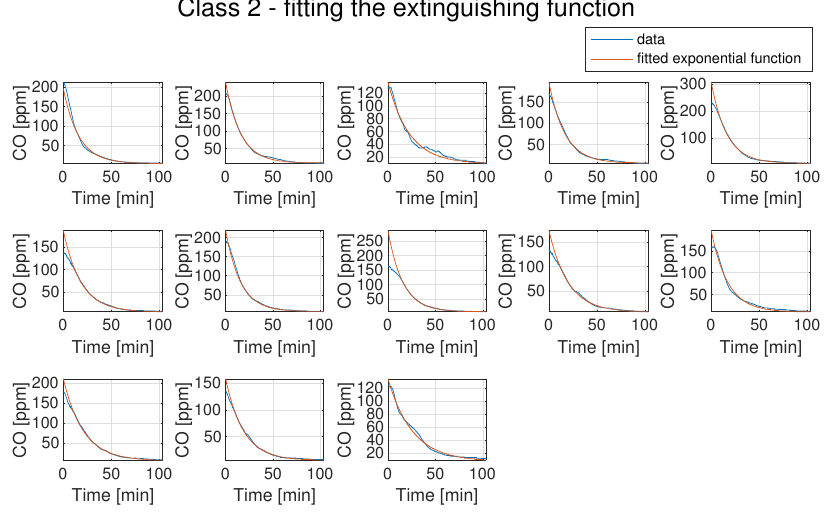
Figure A9. The results of fitting of the deterministic function to the extinguishing process—Part